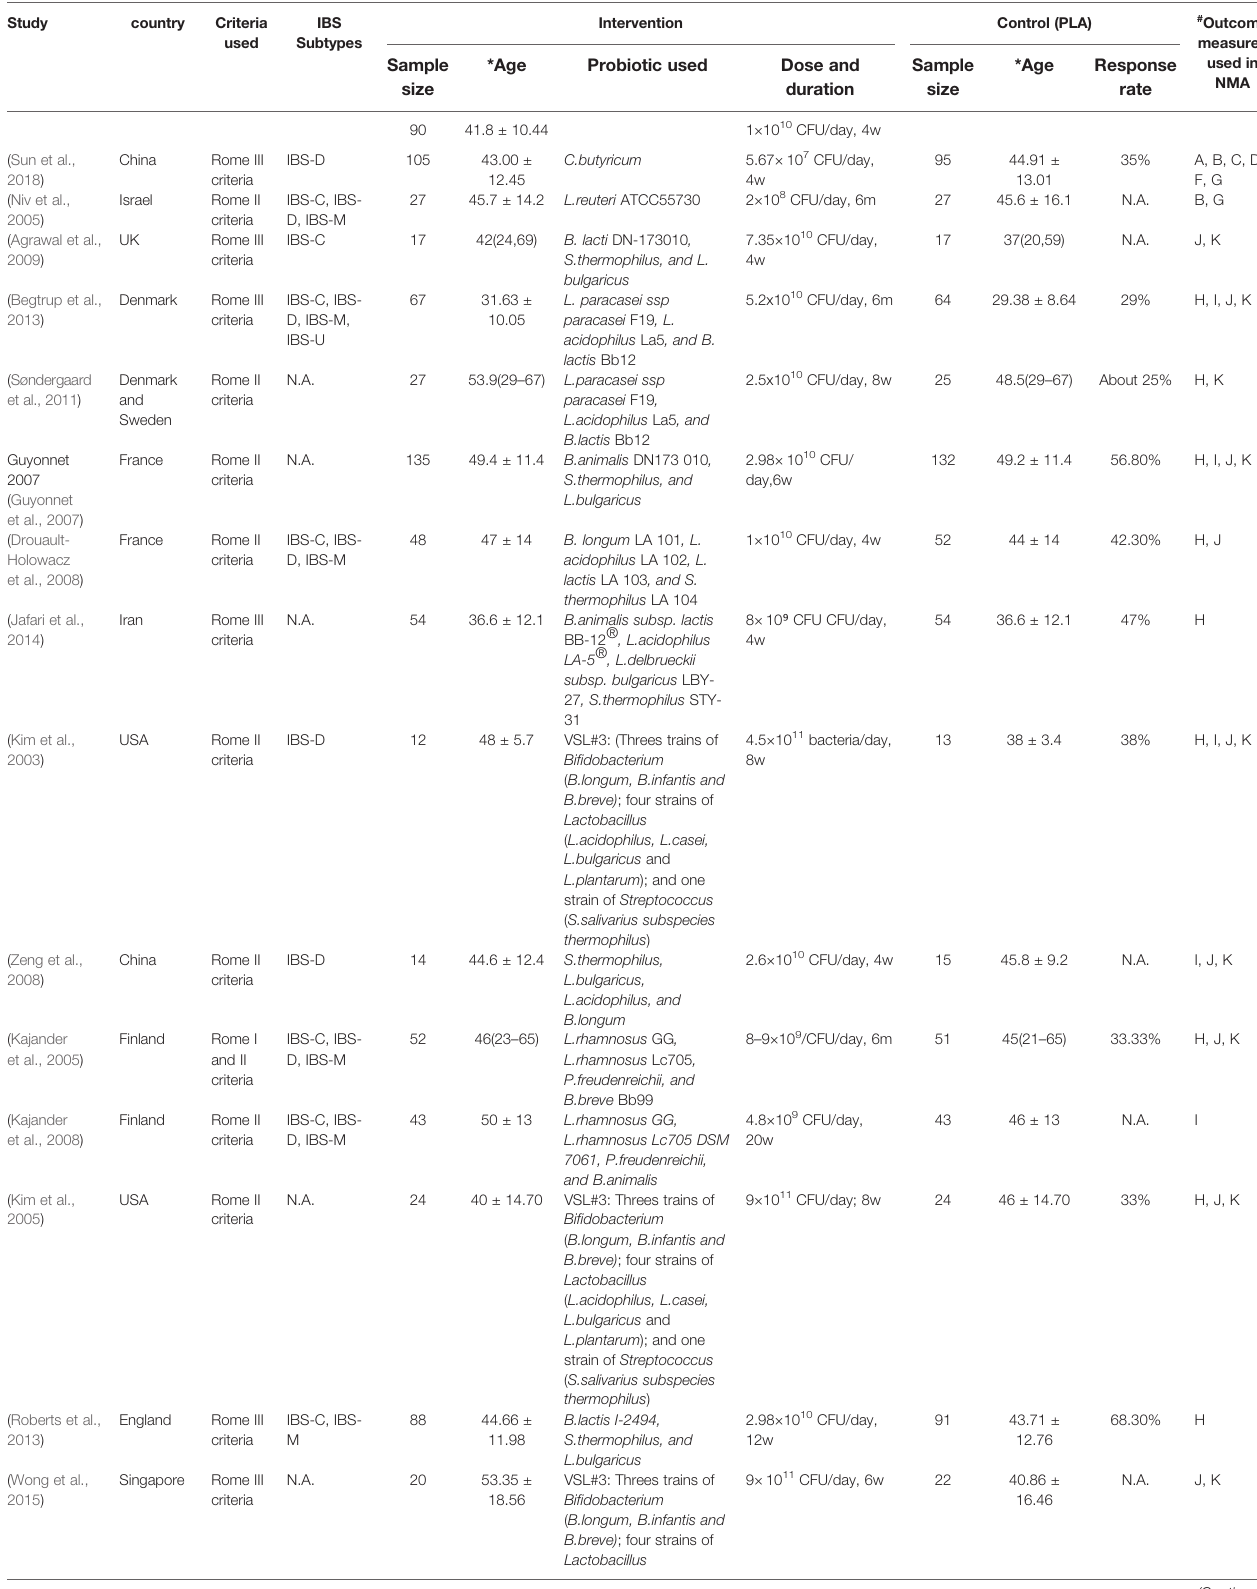
9×10 11 CFU/day, 6w 22 40.86 ±